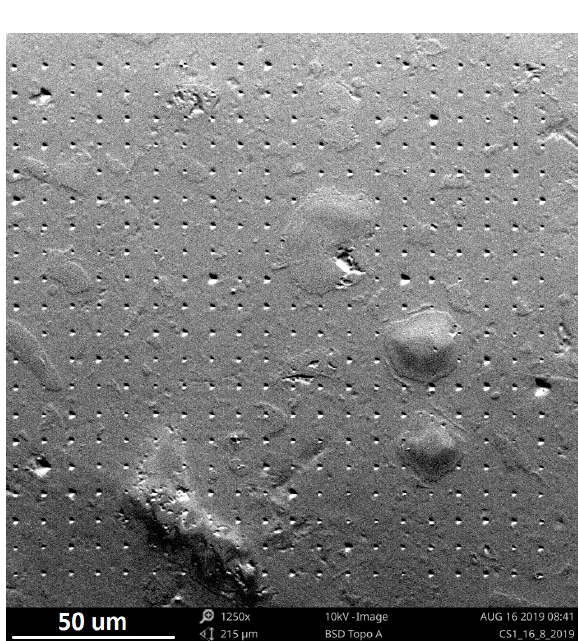
Figure 3. Load function of indents.